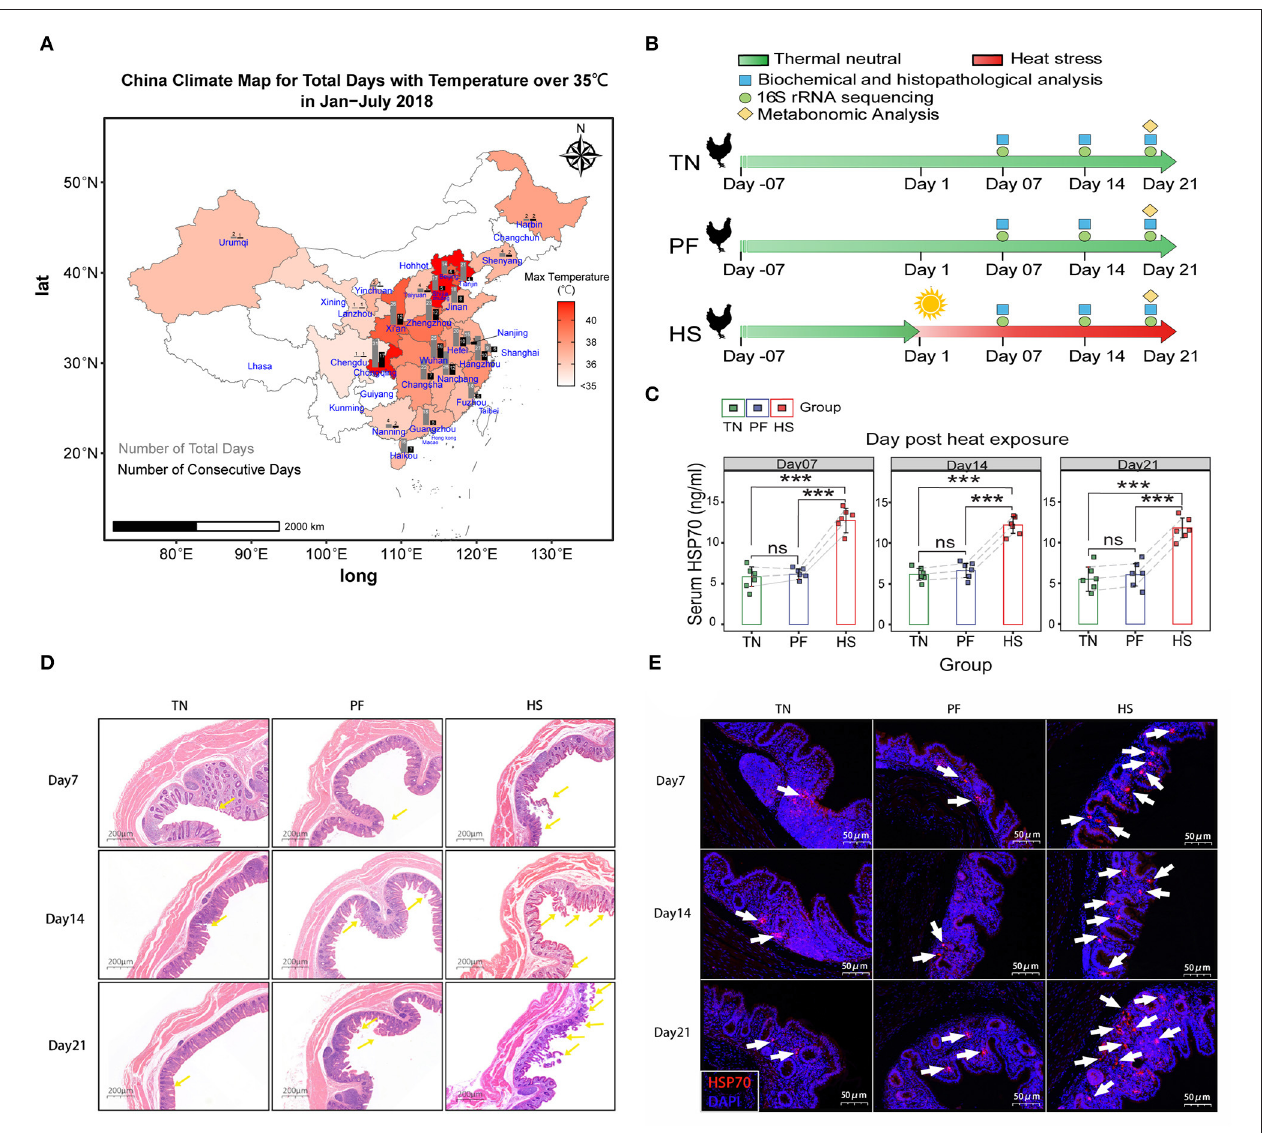
FIGURE 1 | Establishment of chronic heat exposure models of growing hens. (A) China Climate Map for Total Days with Temperature over 35 ◦ C in January–July 2018. Colors represent the max temperatures among different provinces shown in the scale bar next to the charts. The gray bars represent the number of the total days, and black bars represent the number of consecutive days. (B) An overview of the schematic diagram for the time design of the experiment, before heat exposure (day-14), beginning of the heat exposure (Day 1), sampling days 7, 14, and 21. (C) Bar plots showing the level of HSP70 in serum among the TN, PF, and HS groups. All results are expressed as mean ± SD of eight hens in each group. *, **, and *** represent statistical significance at p < 0.05, p < 0.01, and, p < 0.001 levels. ns, denotes no significant difference was found in related groups. (D) Representative hematoxylin–eosin-stained images of (original magnification, 50 × ) of hen cecal tissue at different time points. (E) Representative images of immunofluorescence staining for HSP70 in cecal